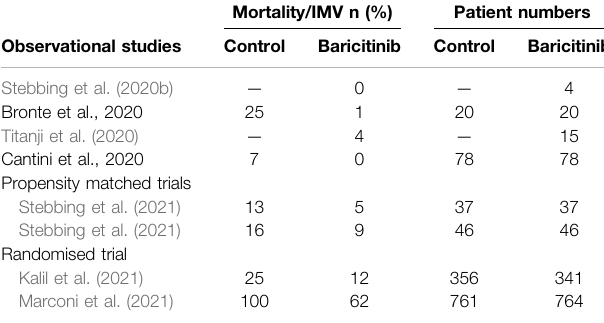
Stebbing et al. (2021)